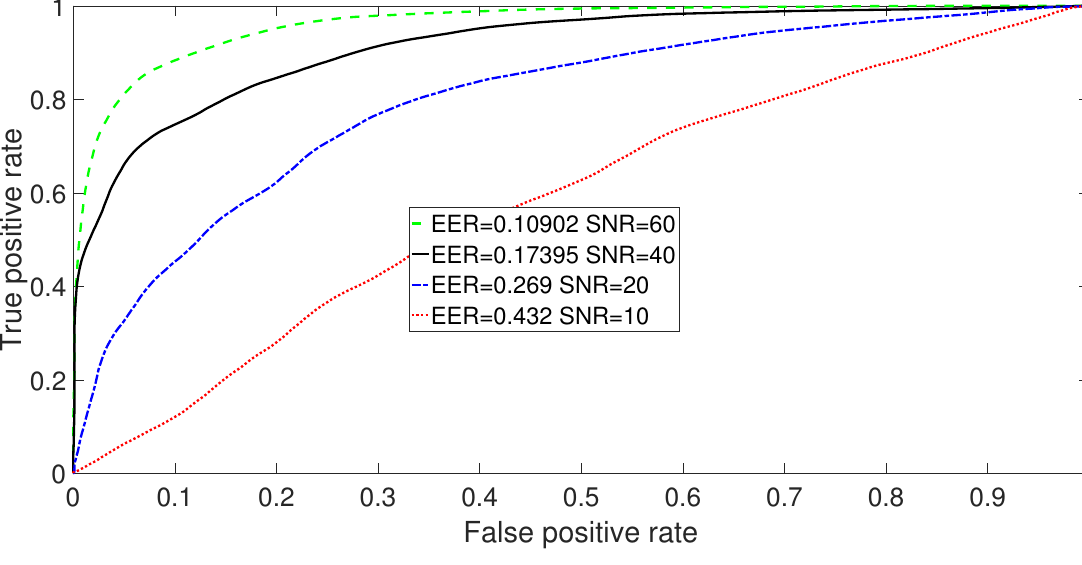
Figure 12. ROCs for the authentication performance between Device 10 and Device 12 for specific values of SNR. SNR is expressed in